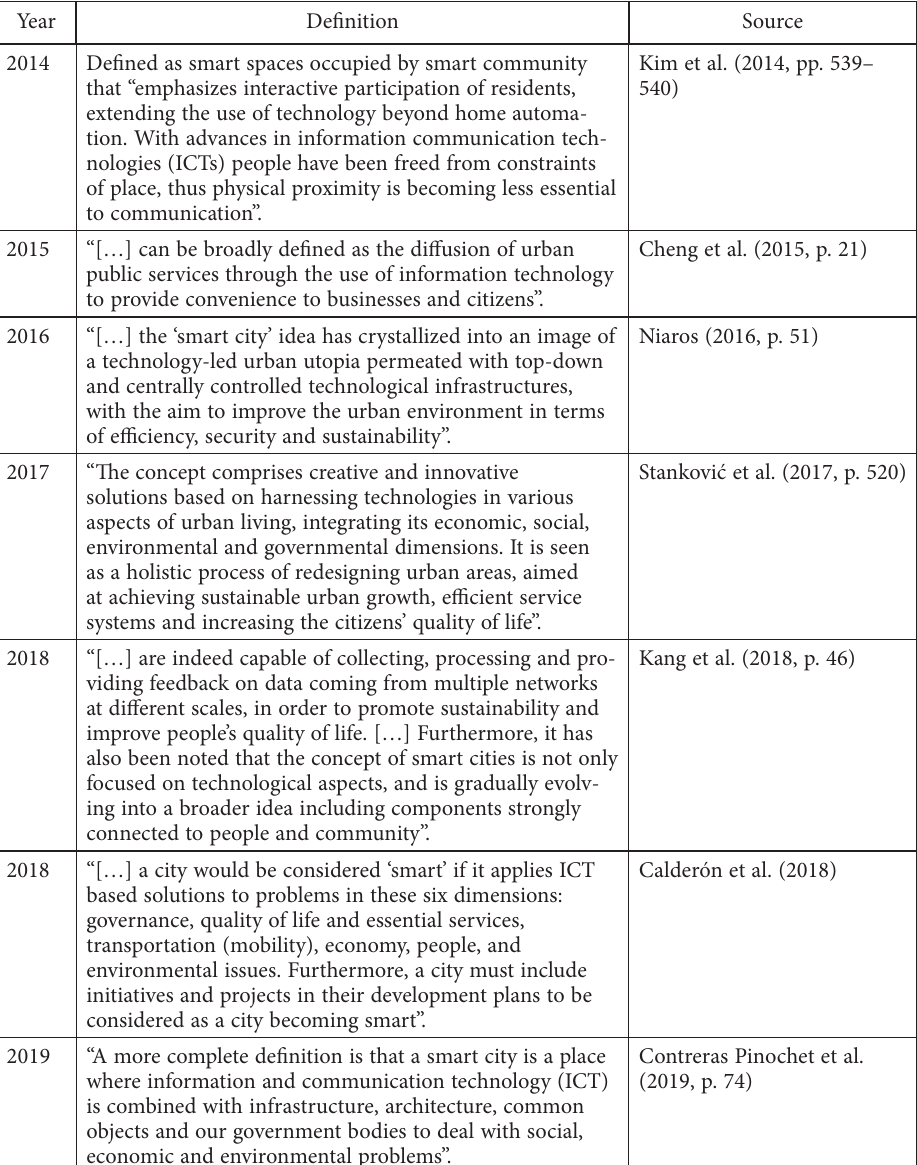
Table 2. Review of definitions of smart city concept found in the analyzed publications (source: created by